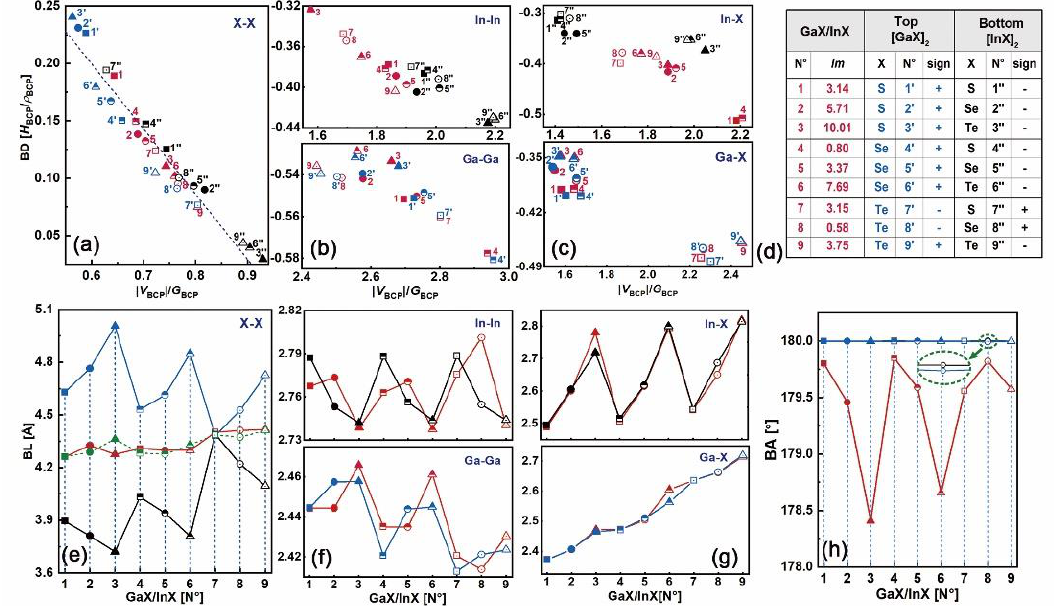
Figure 8. ( a ) BDs vs. | V BCP |/ G BCP at BCPs of X–X, ( b ) M–M and (c) M–X bonds. ( d ) Lattice mismatches ( lm ) in GaX / InX and the resulting signs in the respective top [GaX] 2 and bottom [InX] 2 . ( e ) BLs of X–X, ( f ) M–M, and ( g ) M–X bonds. ( h ) Bond angle (BAs) of X–X bonds. Symbols in red, blue and black colors represent bonds in GaX / InX, top [GaX] 2 and bottom [InX] 2 , respectively. solid square, circle, triangle: N ◦ 1–3, respectively; half-filled square, circle, triangle: N ◦ 4–6, respectively; hollow square, circle, triangle: N ◦ 7–9, respectively. Green dash line in (e) is the average X–X BL of [GaX] 2 and [InX] 2 .